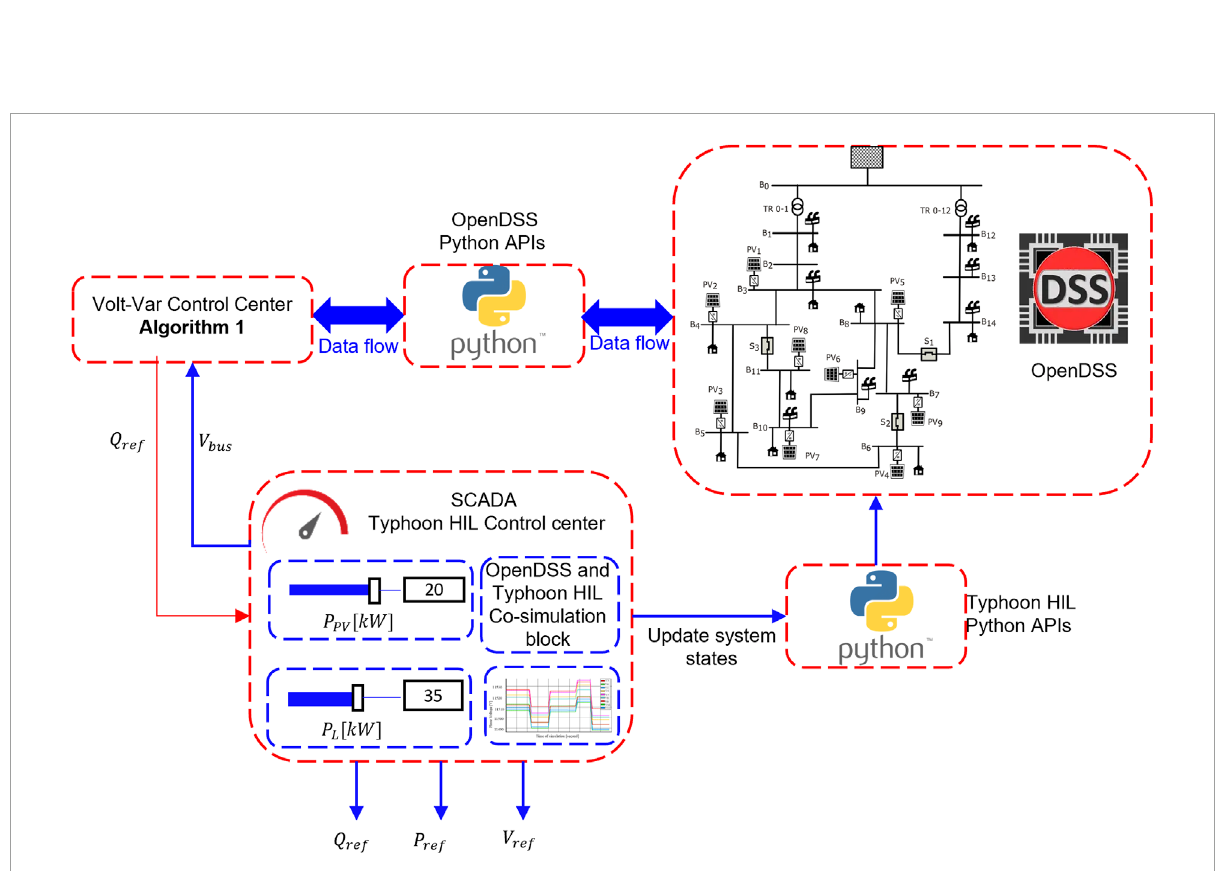
FIGURE 3 Co-simulation between OpenDSS and Typhoon HIL for real-time Volt-Var control.